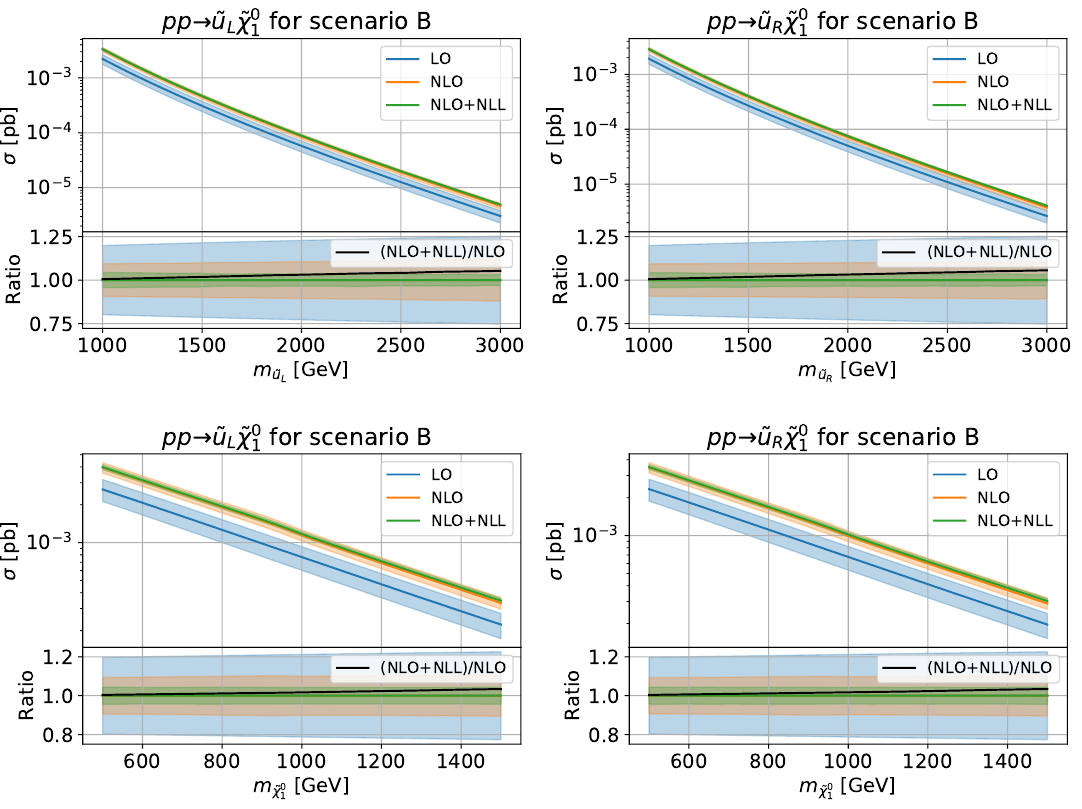
Figure 7. Total cross sections for the processes pp → ˜ u L,R ˜ χ 0 and their relative scale uncertainties 1 (top panels) as well as (NLO+NLL)/NLO K -factors (bottom panels) in scenario B. In the first row, we vary the squark mass m ˜ u , keeping a fixed distance between the left- and right-handed squark L,R masses m ˜ u − m ˜ u = 100 GeV . In the second row, we vary the electroweakino mass m ˜ χ . The other √ L R parameters defining scenario B are not modified. The LHC energy is S = 13 TeV , and we use MSHT20